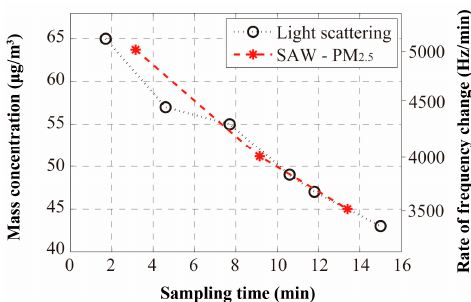
Figure 19. Sensor response comparison between the light scattering monitor and the SAW based PM 2.5 sensor for PSL particles sampling.